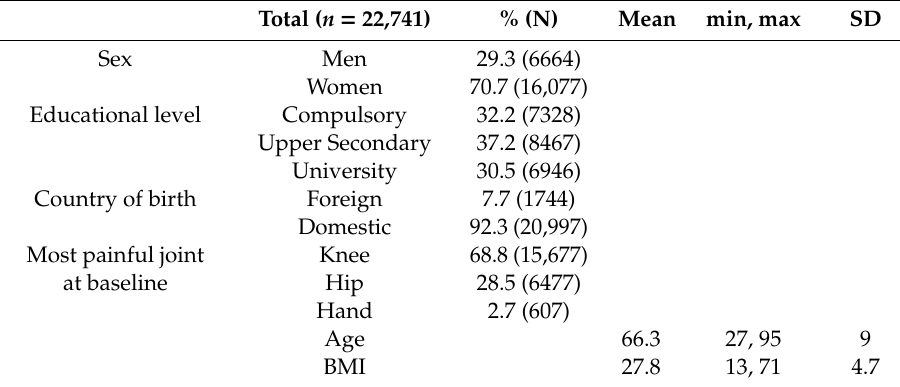
Table 1. Sociodemographic distribution over featured variables.